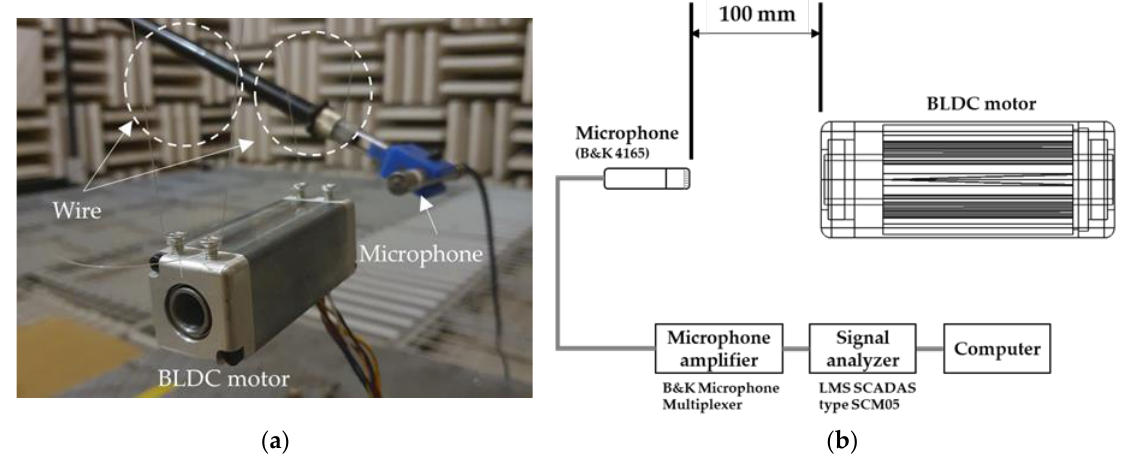
Figure 7. Test setup: ( a ) BLDC motor with the wire boundary condition; ( b ) schematic.